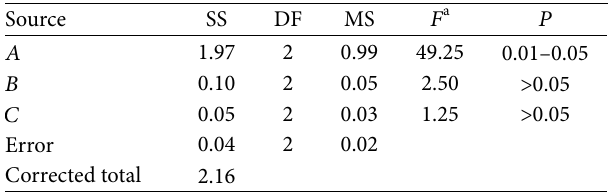
Figure 5: Relationship between the diameter and the three factors with three different levels (a) speed of the stepper motor; (b) moving speed of the nozzle; (c) height from the nozzle to the platform. The statistic was the absolute value of difference between the statistic in Table 5 and 0.6 mm, the ideal diameter of the fiber. Table 6: Analysis of variance for the orthogonal